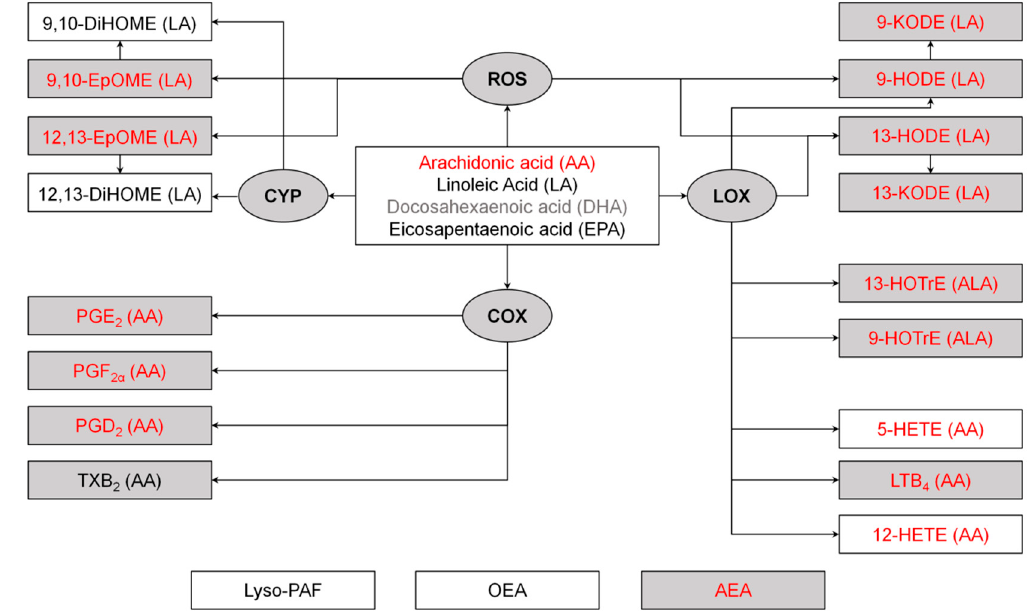
Figure 2. Mechanisms of biosynthesis of lipid mediators. Metabolites of arachidonic acid (AA), linoleic acid (LA) and alpha-linolenic acid (ALA) are divided into the groups synthesized via lipoxygenase (LOX), cyclooxygenas (COX), cytochrome P450 monooxygenase (CYP) or reactive oxygen species (ROS) dependent pathways. The other abbreviations are as follows: AEA,